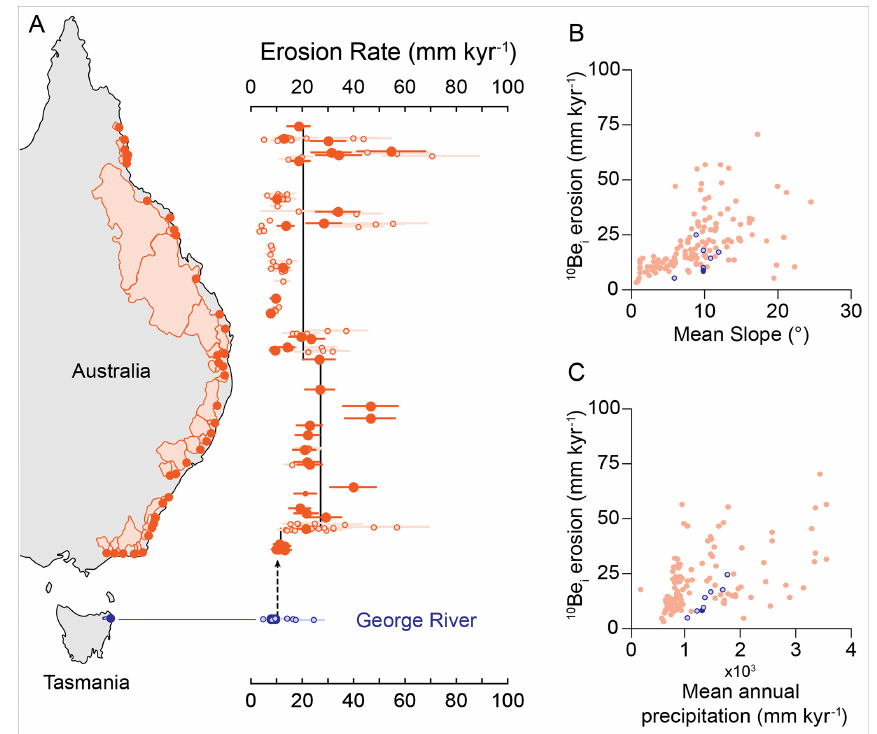
Figure 10. (a) Map of river basins draining east off the Great Australian Escarpment, where 10 Be i erosion rate data are available; figure adapted from Codilean et al. (2021). Filled circles are trunk streams and open circles are tributaries. Orange data include previously pub- lished data (Codilean et al., 2021; Croke et al., 2015; Fülöp et al., 2020; Godard et al., 2019; Nichols et al., 2014; Tomkins et al., 2007). Blue data are new data presented in this study from the George River basin, Tasmania. The average 10 Be i erosion rates from the George River (8.9mmkyr − 1 ) are consistent with erosion rates from southeast mainland Australia (average 11.6mmkyr − 1 ; Codilean et al., 2021). (b) Comparison of 10 Be i erosion rates from the George River basin (blue circles; tributaries) and the eastern flanks of the Great Australian Escarpment (orange circles) to basin average slope. (c) Comparison of 10 Be i erosion rates from the George River basin (blue circles) and the eastern flanks of the Great Australian Escarpment (orange circles) to mean annual precipitation; in this comparison, mean annual precip- itation for George River samples comes from the elevation scaling for measured rainfall at meteorological gauging stations (Figs. 2 and 3, Table 1), whereas Codilean et al. (2021) summarize precipitation data for mainland basins from the WorldClim database (Fick and Hijamans,